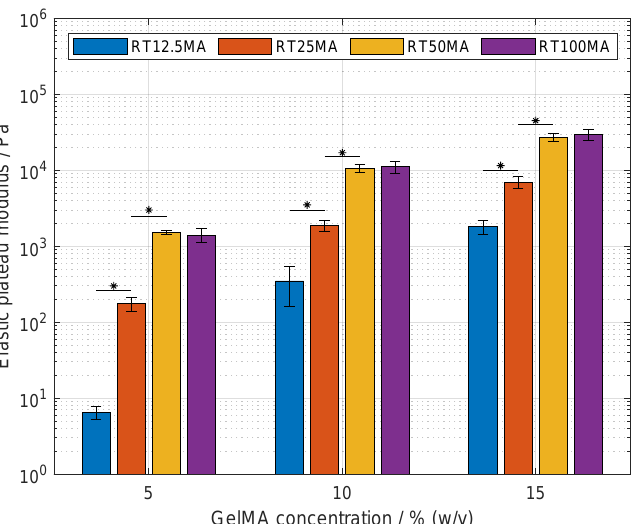
Figure 4. Elastic plateau modulus of gelatin methacryloyl (GelMA) hydrogels at various concen- trations. The elasticity of hydrogels increased significantly with higher GelMA concentrations of the same synthesized sample ( p < 0.05). These differences are not shown for the purpose of clarity. Significant differences between the elastic modulus of samples at a constant GelMA concentration are denoted with an asterisk ( p <